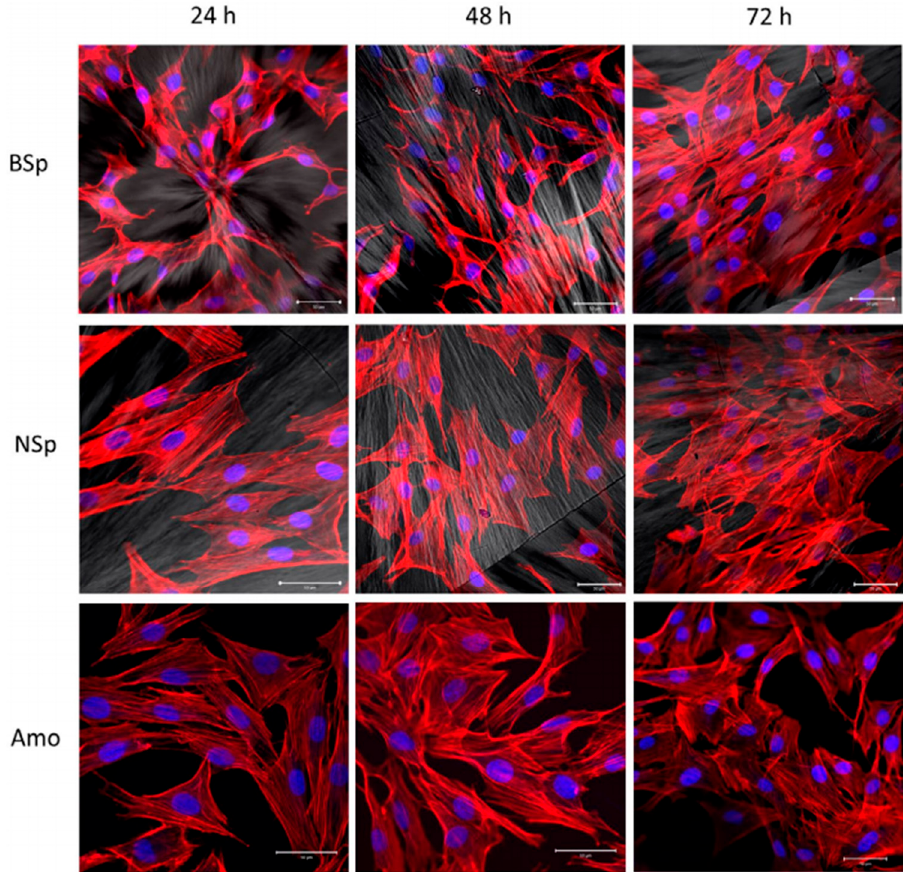
Figure 9. Morphology of MC3T3-E1 cells cultured on PLLA surfaces. Cells were stained with Alexa Fluor 568 (red) and DAPI (4 ′ ,6-diamidino-2-phenylindole; blue). The scale bar represents 50 μ m. Crystallization temperatures for normal spherulite samples (NSp) and ring-banded spherulite samples (BSp) were 150 and 143–147 °C, respectively. For preparing amorphous PLLA films (Amo), the molten state samples were quenched into ice water [60].